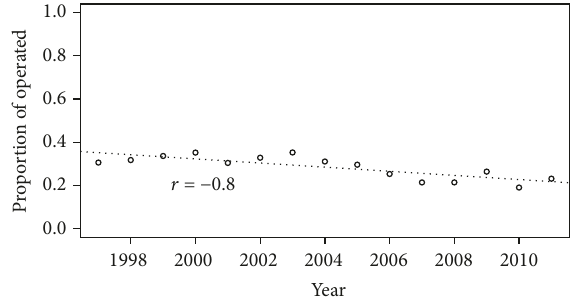
Figure 6: Annual proportion of surgically treated patients with C2 fractures.